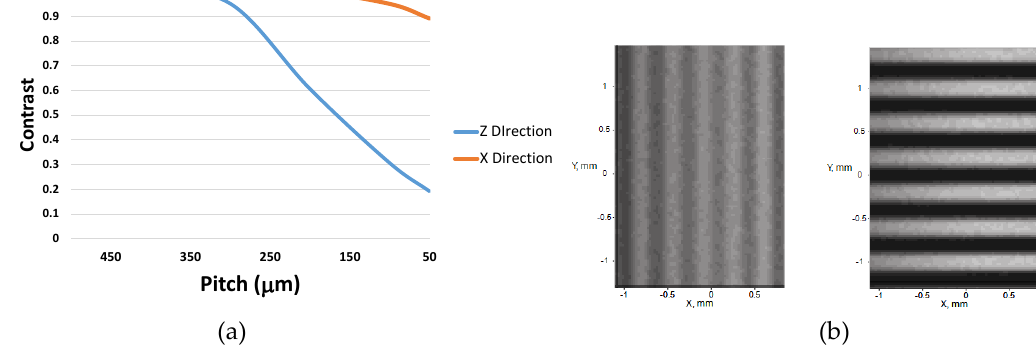
Figure 4. (a) Analysis chart of contrast when the light source divergence angle is 0.5 degrees and the fingerprint periods in the x direction and the z direction are changed. (b) Energy distribution of the fingerprint ridge and valley on the CMOS sensor.